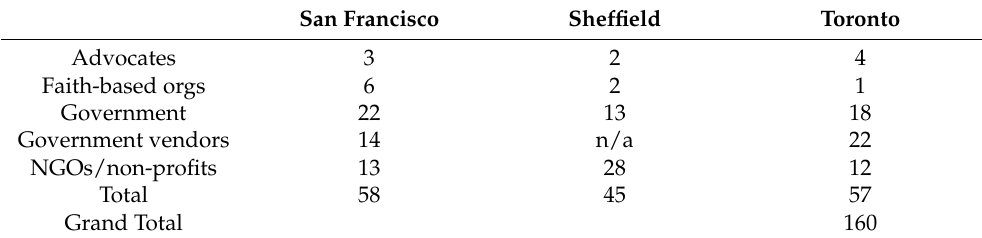
Table 1. Interviews by city and